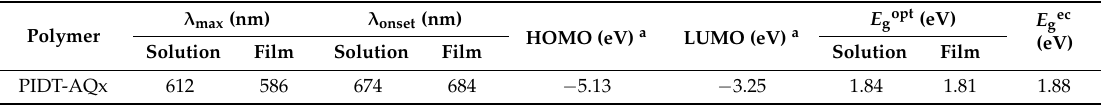
Figure 2. Normalized absorption spectra of PIDT-AQx in chloroform solution and thin film state ( a ) and the molar coefficient of PIDT-AQx in chloroform solution (10 − 6 M) ( b ).